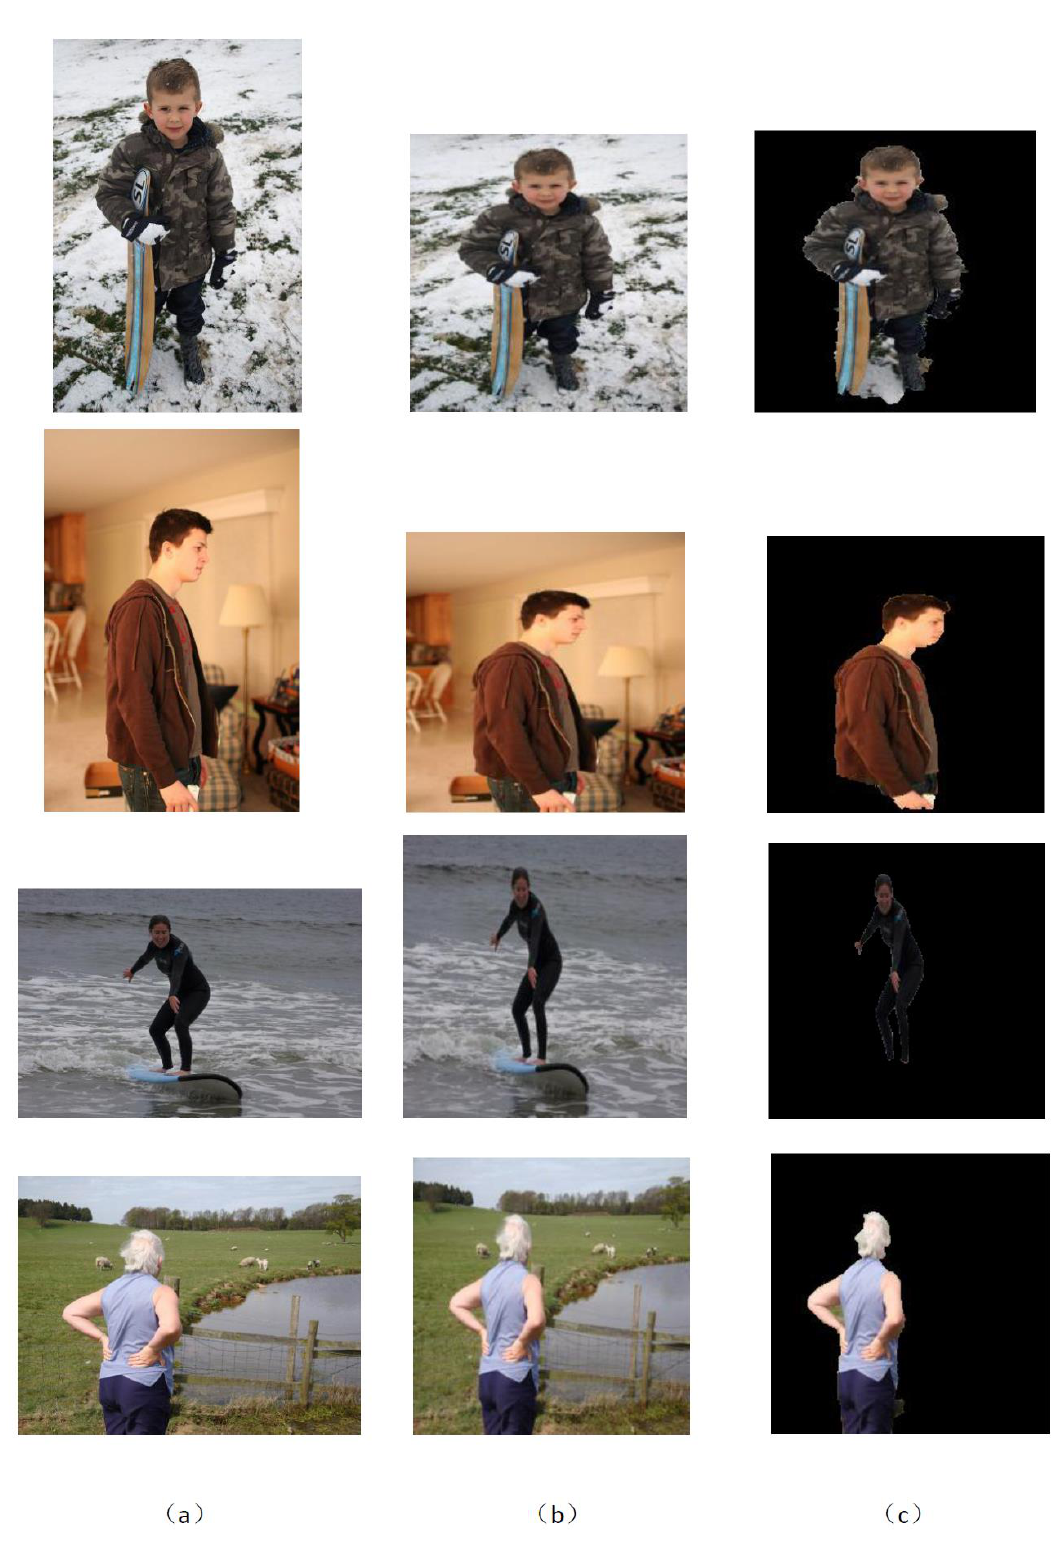
Figure 10. GrabCut-based segmentation experiment results for person objects in COCO dataset: ( a )